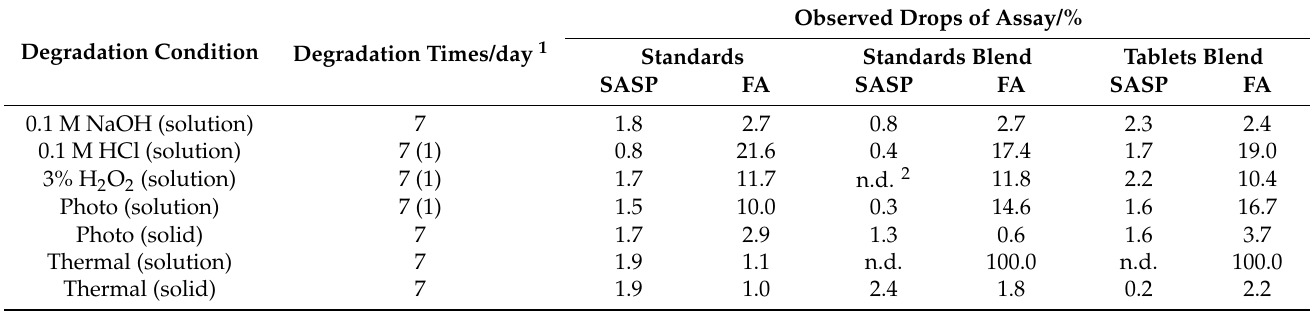
Table 4. Forced degradation study